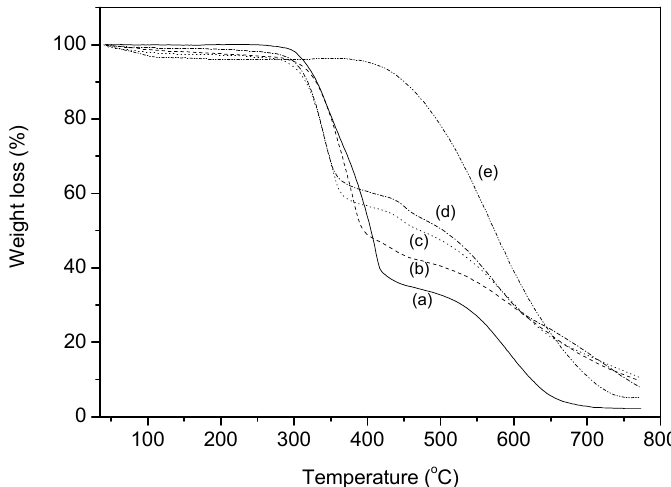
Figure 3. Thermogravimetric analyzer (TGA) curves of samples: ( a ) P[VBTMA][PF 6 ]; ( b ) P[VBTMA] [PF 6 ]-c-PANI (10 wt %); ( c ) P[VBTMA][PF 6 ]-c-PANI (20 wt %); ( d ) P[VBTMA][PF 6 ]-c-PANI (40 wt %); ( e ) PANI.